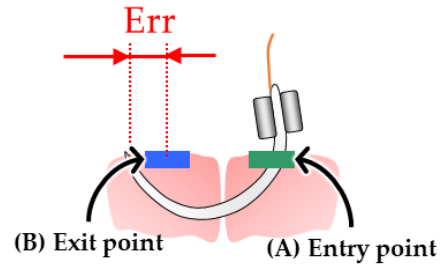
Figure 5. Definition of error.